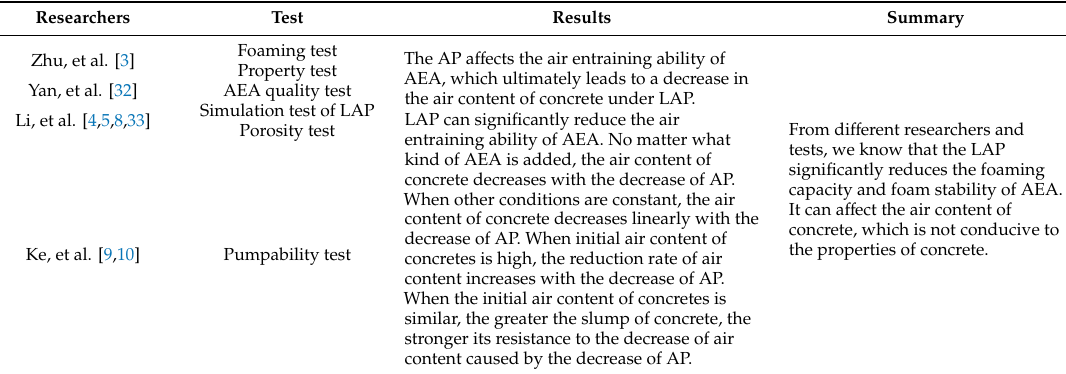
Table 5. Influence of low atmospheric pressure (LAP) on AEA e ff ect in